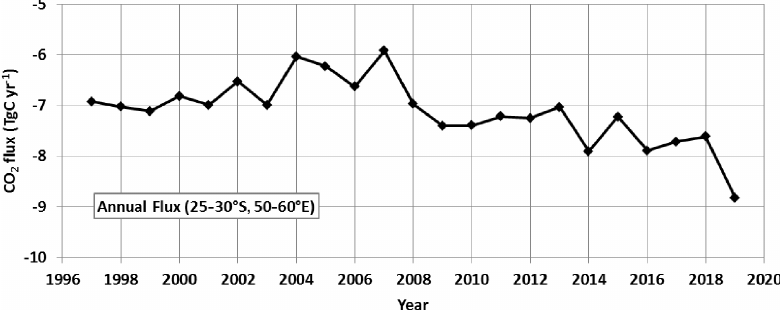
Figure 11. Annual air–sea CO 2 flux (TgCyr − 1 ) in the south-western Indian Ocean (region of 25–30 ◦ S, 50–60 ◦ E) for the period 1996–2019 from the CMEMS-LSCE-FFNN model. The carbon uptake progressively increased after 2007 with a maximum CO 2 sink estimated in 2019 when the SEMB was particularly